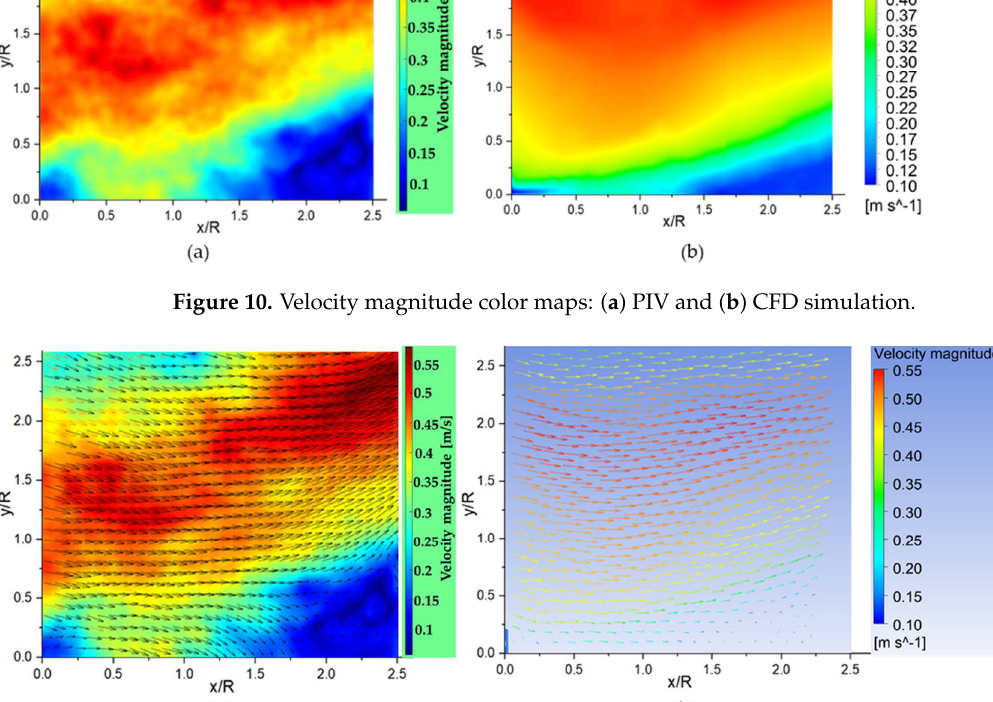
Figure 11. Velocity vectors: ( a ) PIV and ( b ) CFD simulation.